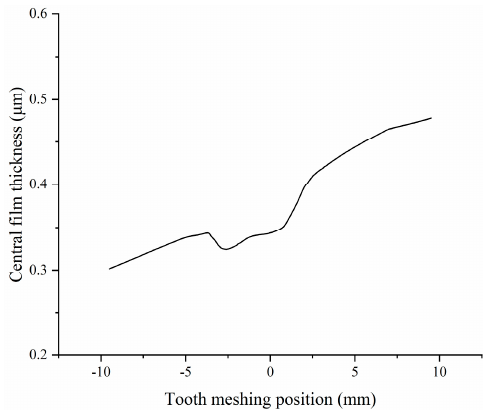
Figure 5. The curve of the central film thickness.